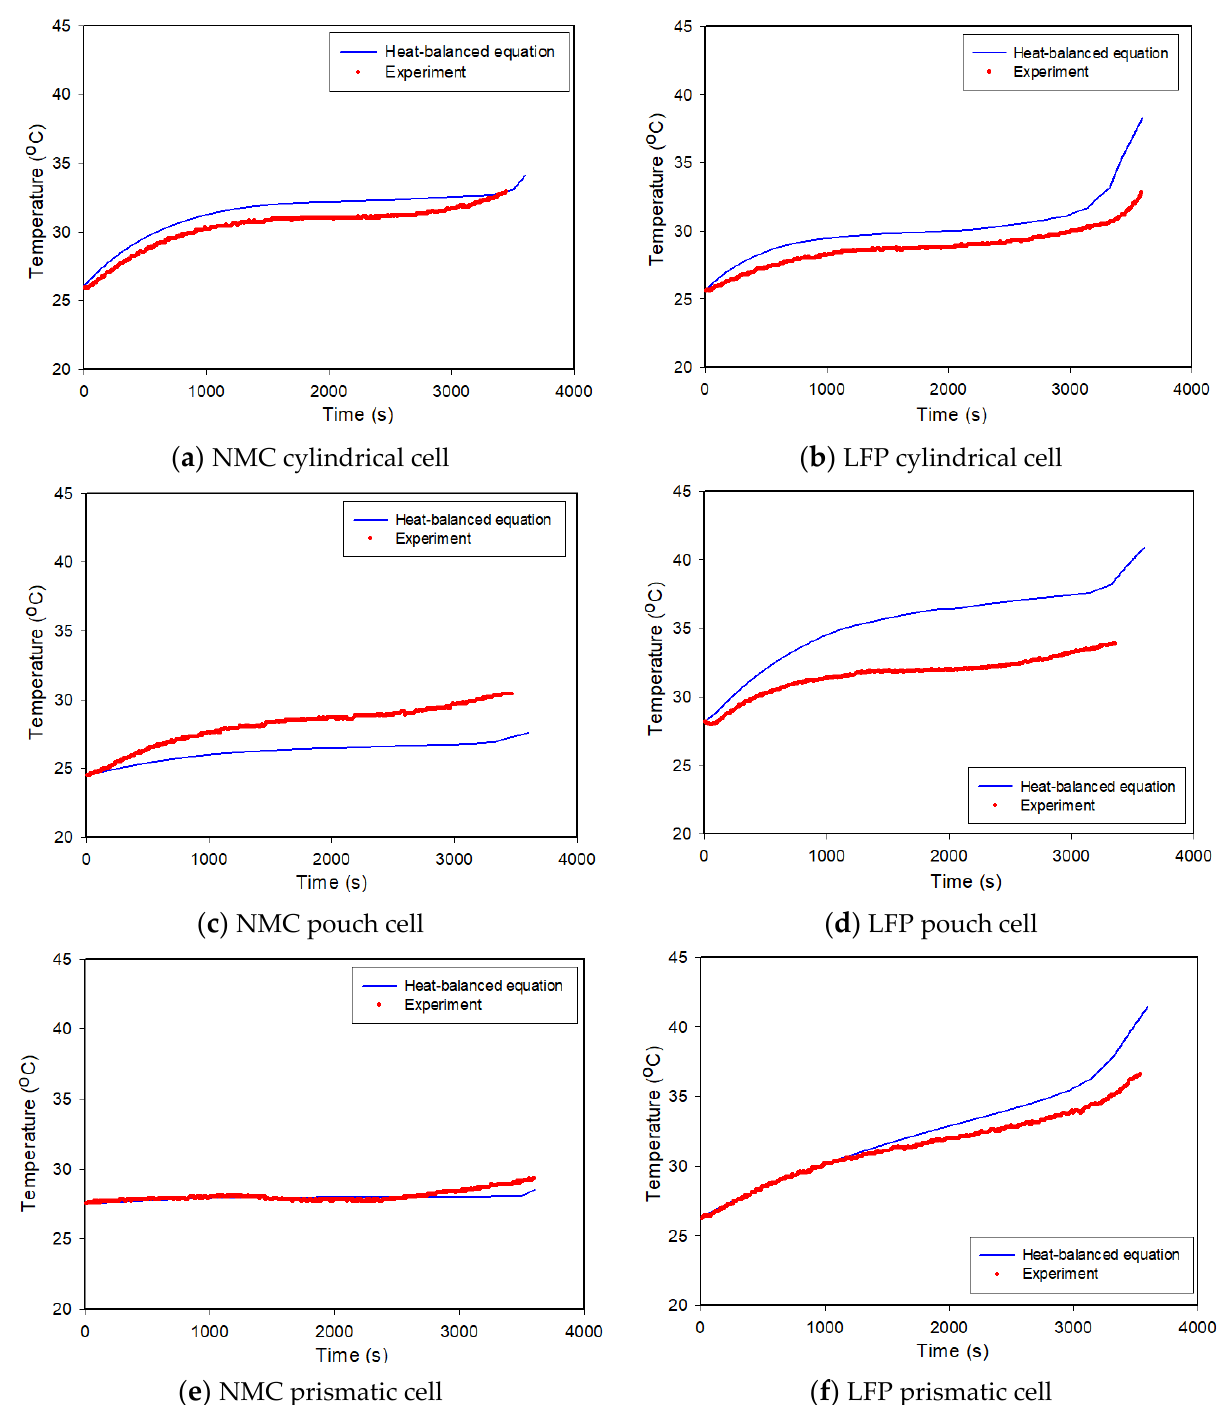
Figure 12. The prediction of battery surface temperatures using the heat balance equation as com- pared with the experimental results: ( a ) NMC cylindrical, ( b ) LFP cylindrical, ( c ) NMC pouch, ( d ) LFP pouch, ( e ) NMC prismatic, and ( f ) LFP prismatic.